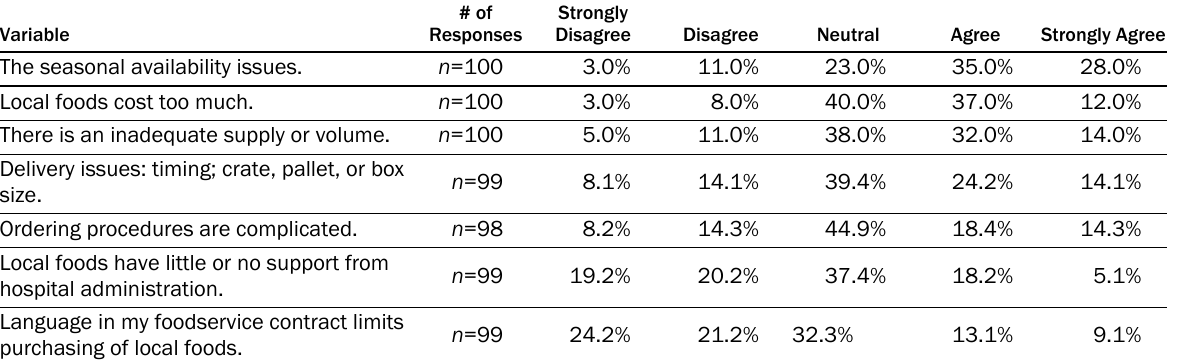
Table 7. Attitudes as Measured by Inquiring About Potential Problems Variable